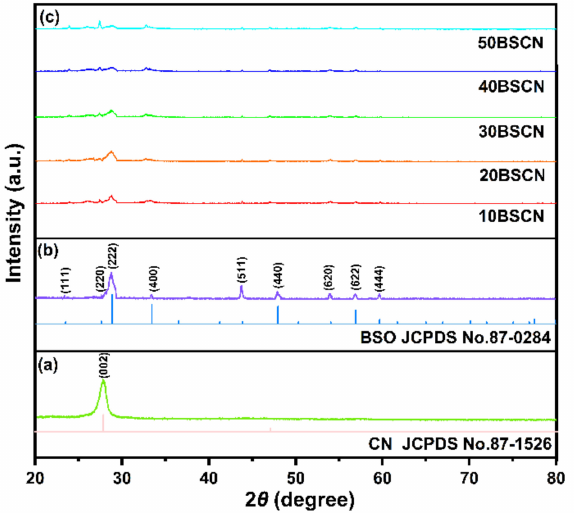
Figure 1. XRD patterns of CN ( a ), BSO ( b ), 10BSCN, 20BSCN, 30BSCN, 40BSCB, and 50BSCN ( c ).